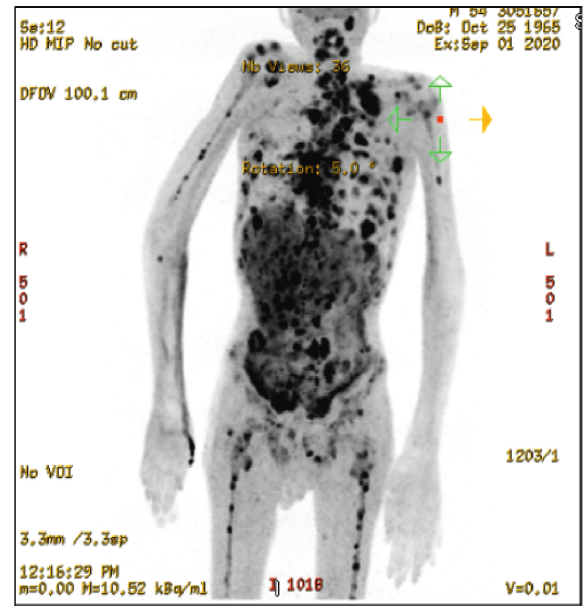
Figure 2: PET/CT scan of the patient admitted to the emergency